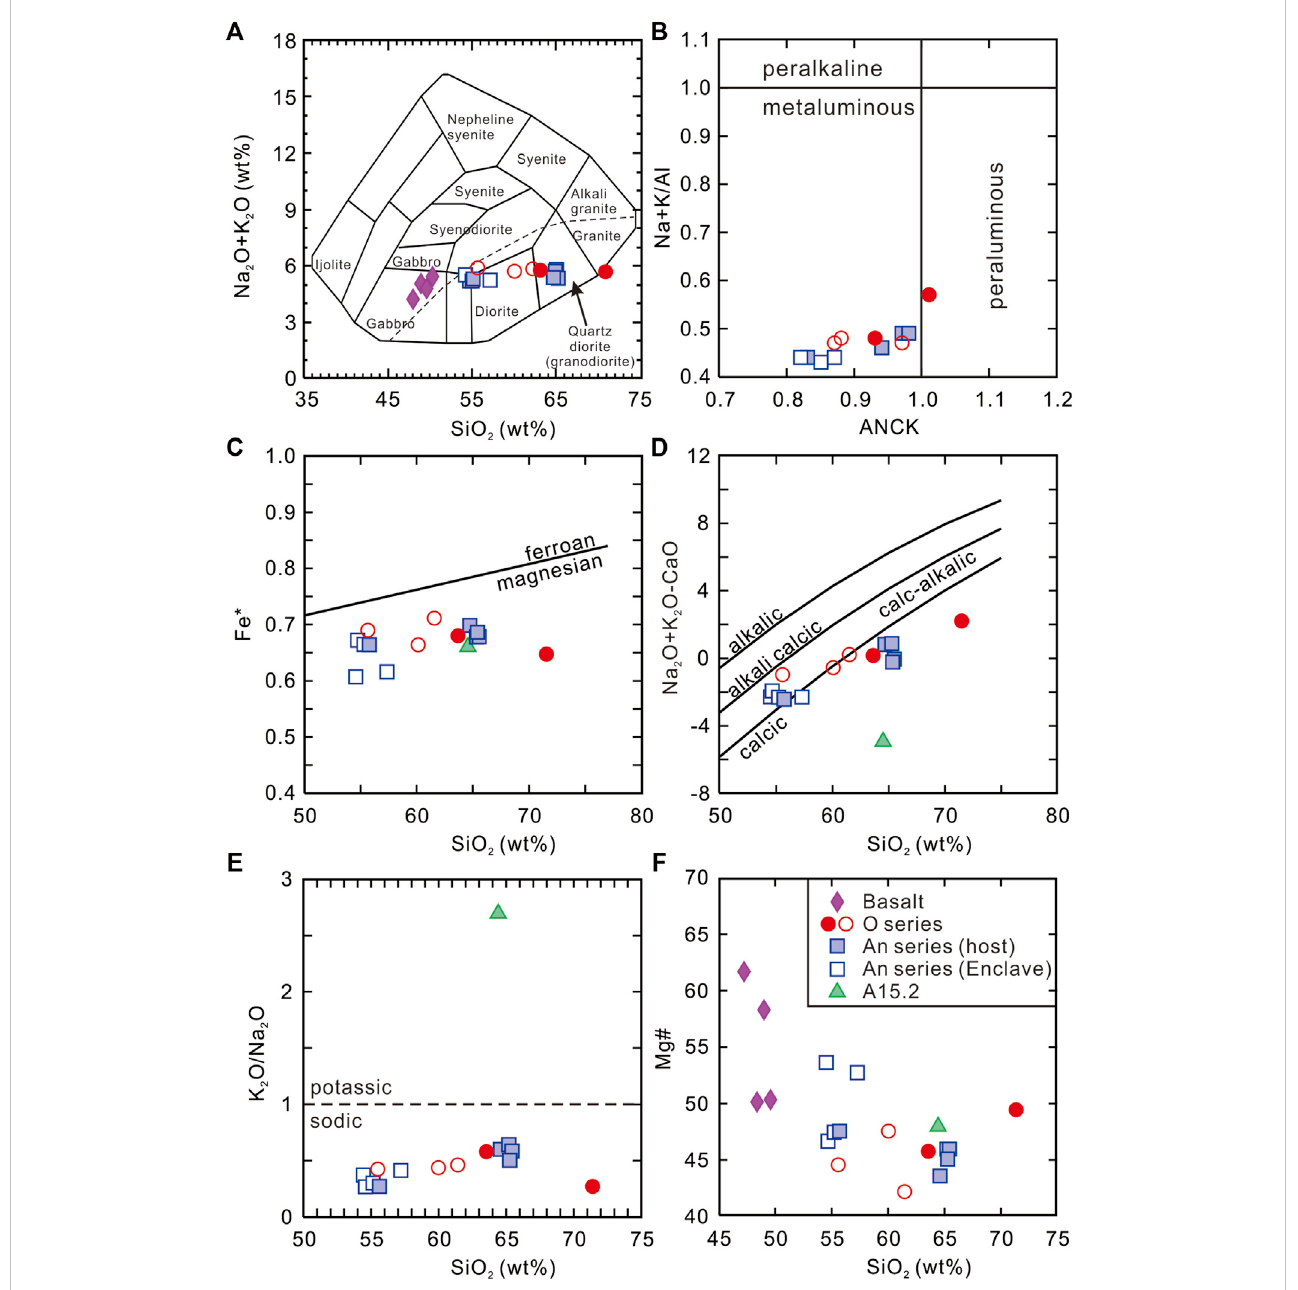
FIGURE 7 Chemical classi fi cation of the rocks from the Snoul pluton. (A) Na 2 O + K 2 O (wt%) vs. SiO 2 (wt%) classi fi cation of rocks (Cox et al., 1979). (B) Alkali index (mol. Na+ K/mol. Al) versusaluminum saturation index(ASI= mol.Al/mol. Ca +Na +K). Classi fi cation ofthequartz dioritic anddioritic rocksusing (C) theFe* [(FeOt/(FeOt + MgO)] value and (D) the modi fi ed alkali-lime index (Na 2 O + K 2 O-CaO) vs. SiO 2 (wt%) of Frost et al. (2001). (E) K 2 O/Na 2 O vs. SiO 2 showing the sodic nature of the rocks. (F) Mg# vs. SiO 2 (wt%) of the ma fi c and silicic rocks from the Snoul pluton.